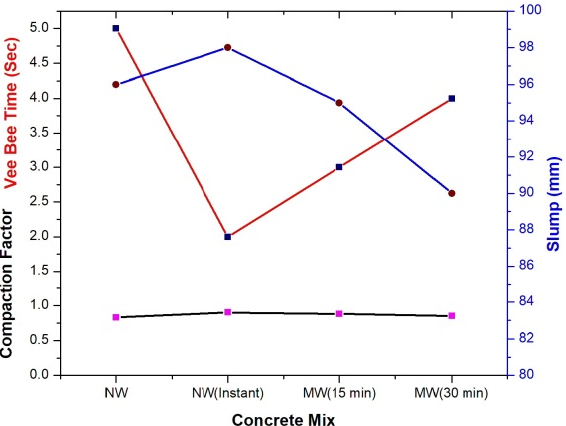
Figure 8. Fresh concrete properties (NW with 1% optimized SP and MW with 0% SP).